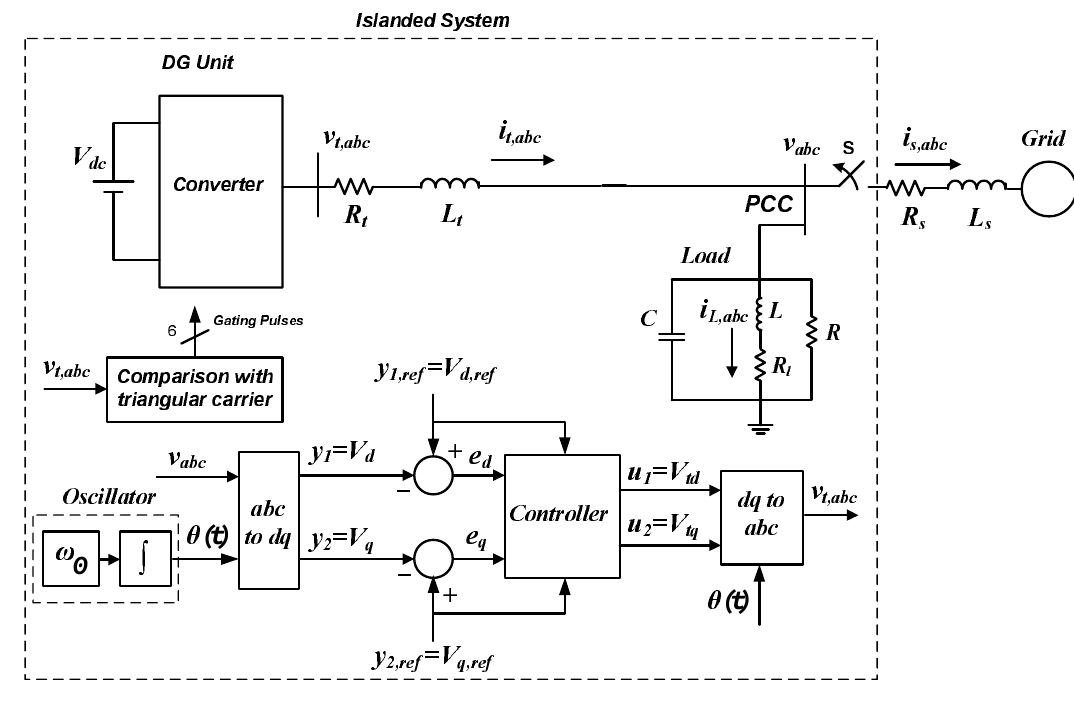
Figure 6. Schematic diagram of the islanded system and its controller.